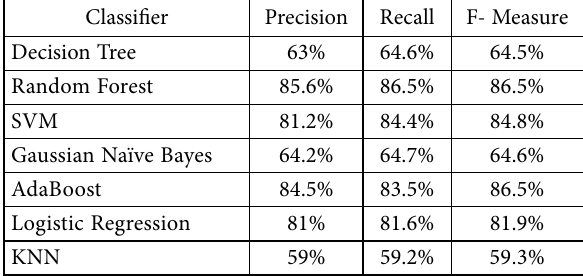
Table 5. Accuracy of classifier for tweets sentiment